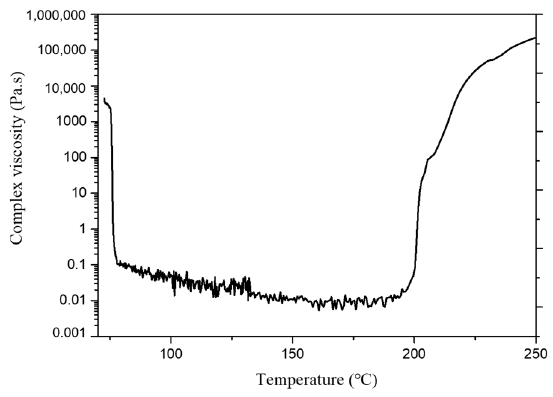
Figure 4. Temperature ramp rheology measurement of T–Fa.